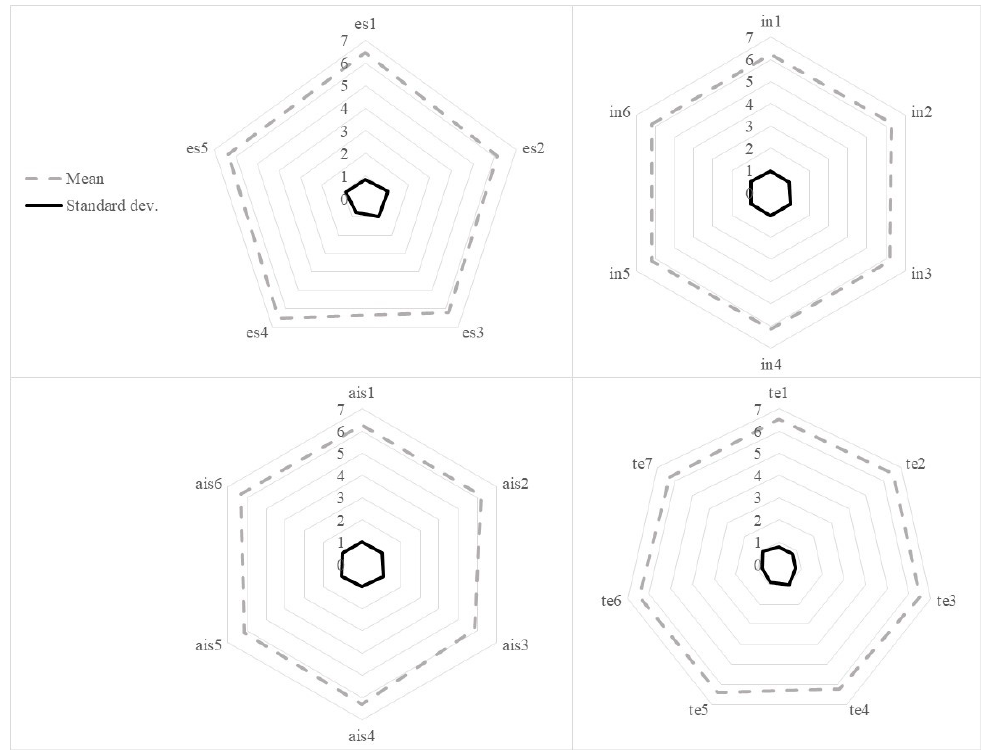
Figure 4. Measurements descriptive.